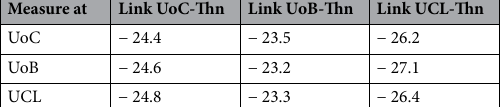
Table 2. Estimated NSR (dB) of network links, at 16 channel full load 21 .